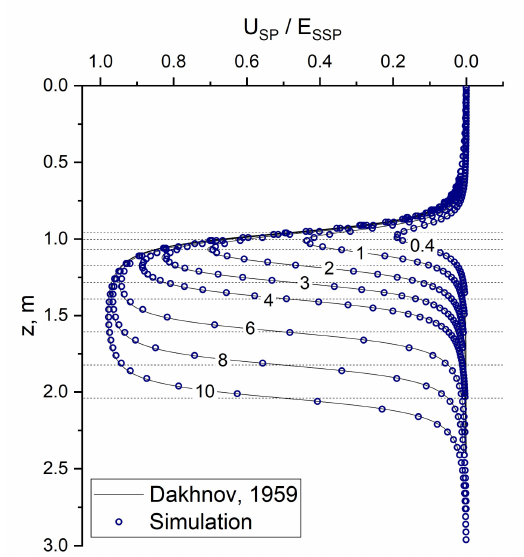
Figure 5. SP logging curves normalized to the static SP value from the thickness of the permeable formation. The cyphers of the corresponding curves denote the ratio of reservoir thickness to borehole radius. Circles are the results of calculation with the proposed numerical algorithm; the solid line is the calculation according to the analytical formula presented in